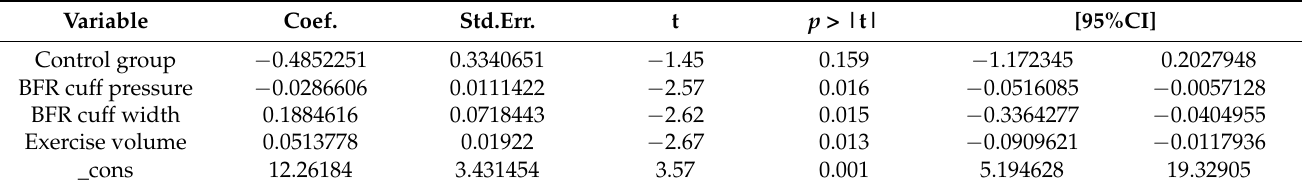
Table 2. Results of meta-regression analysis on acute hemodynamic response outcomes.